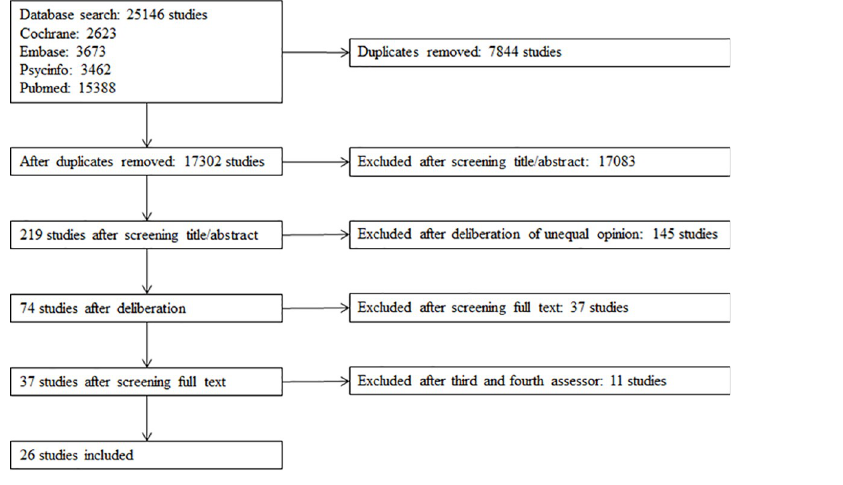
Fig 1. Flowchart of included